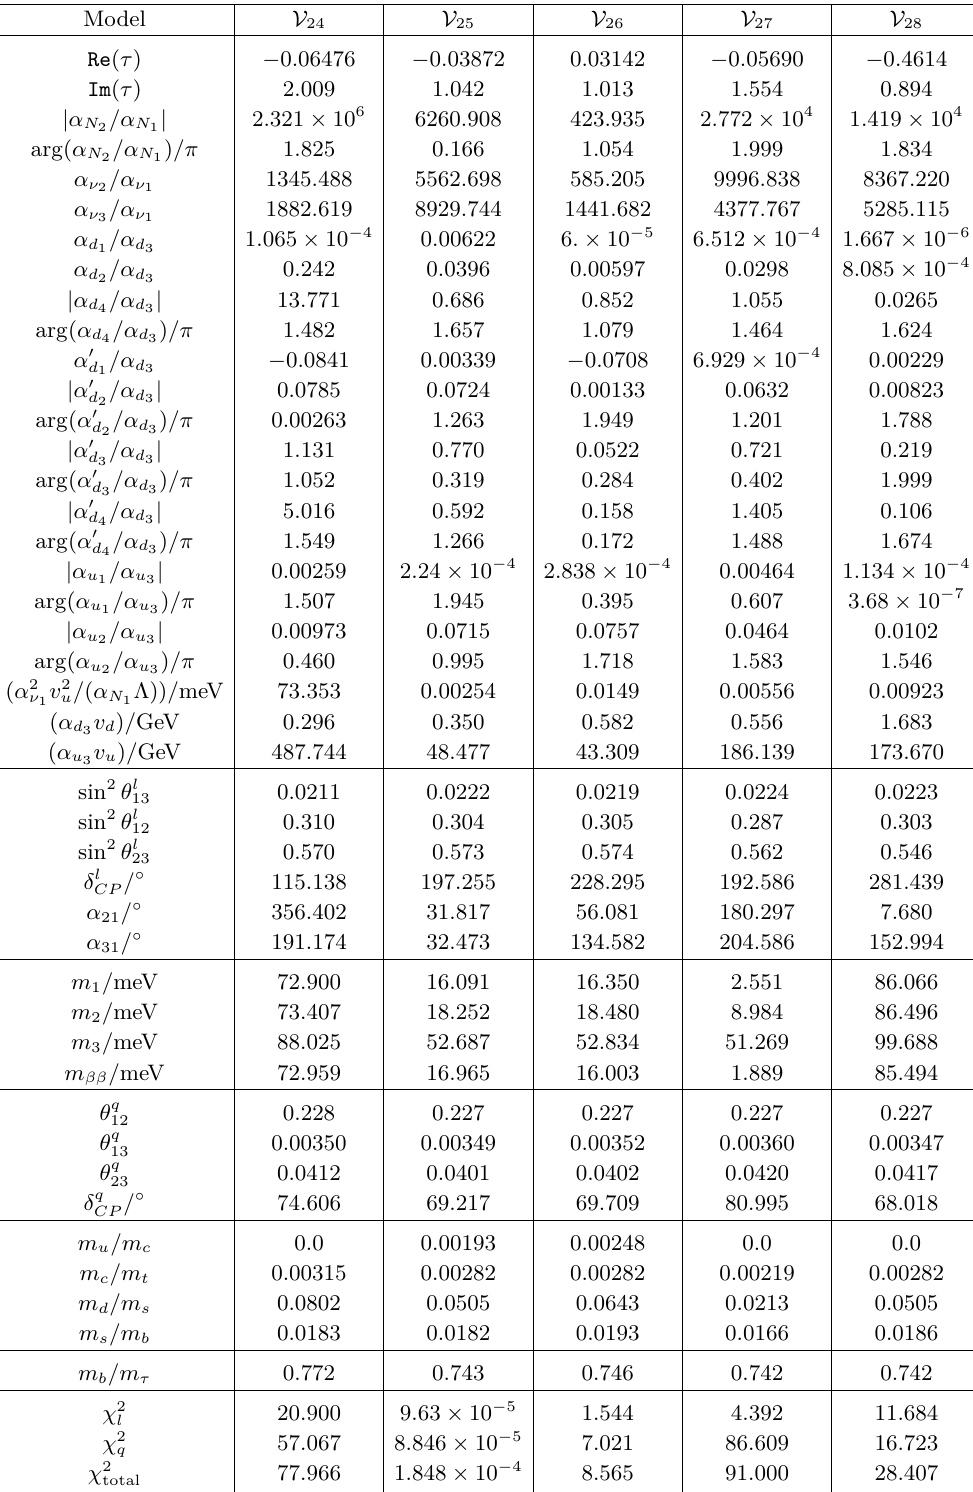
Table 14 . The best fit values of the free parameters and the corresponding predictions for lepton and quark mixing parameters and fermion masses for the phenomenologically viable models of Type-V (continuation of table